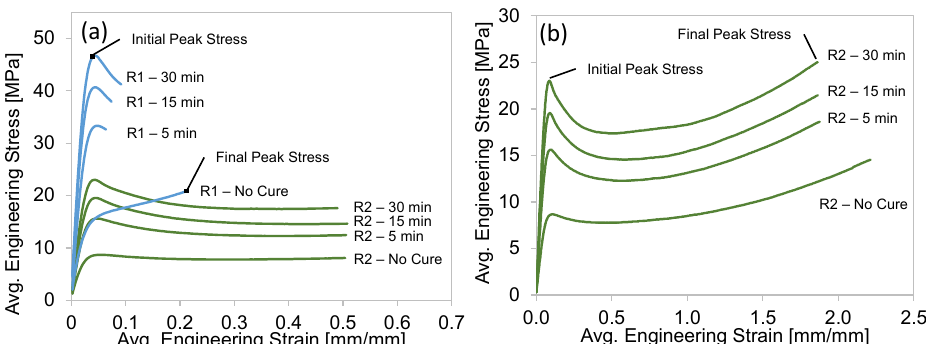
Figure 5. ( a ) The effect of UV cure time on the average stress–strain response for Resin 1 (R1) and Resin (R2). The R2 curves terminate at the maximum range of the clip-on extensometer. ( b ) The average stress–strain response of R2, where the crosshead displacement was used to determine failure strain.